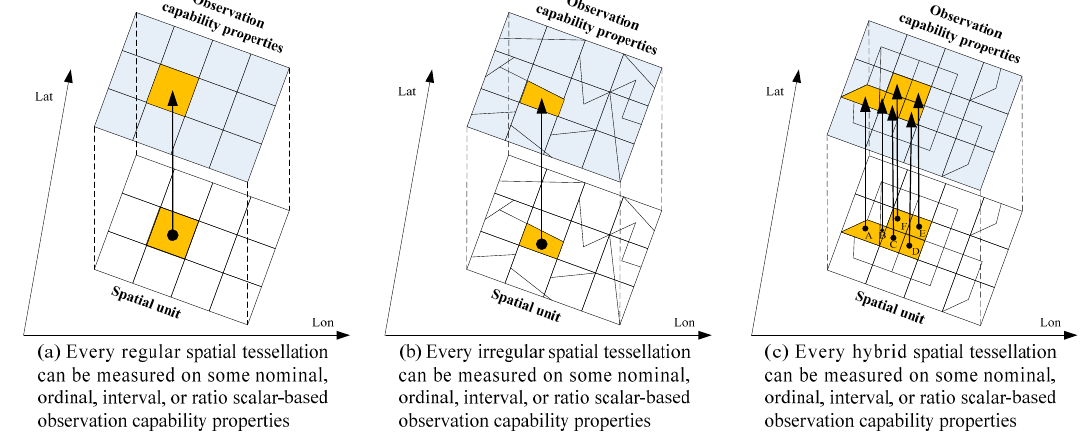
Figure 1. Observation capability information representation from different spatial tessellations of the field modeling perspective.